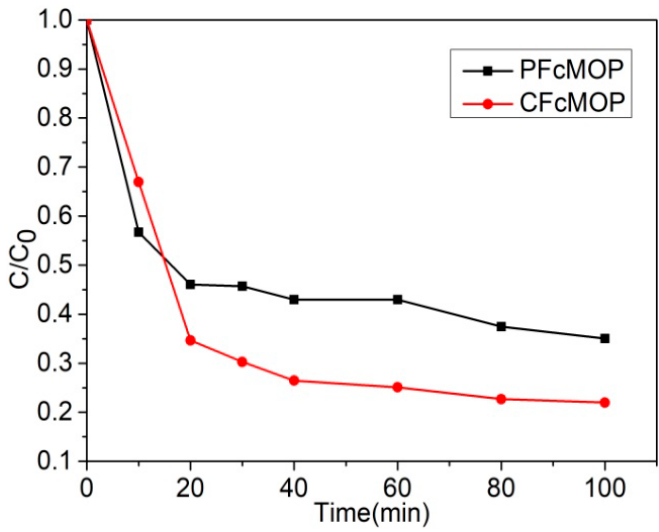
Figure 5. Concentration curves with time.